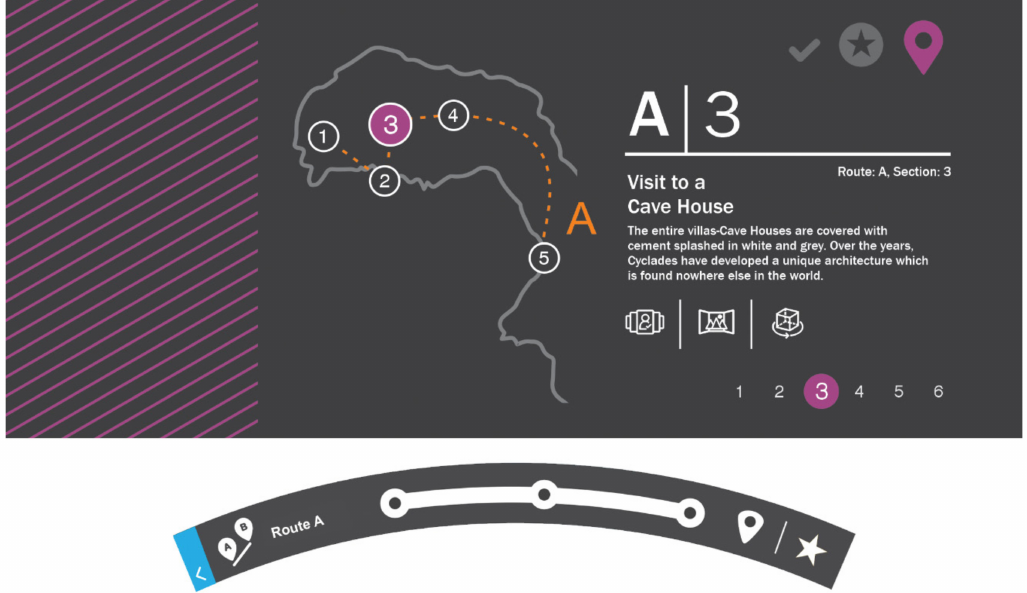
Figure 18. Specially planned route with the interaction bar changed into a tour mode